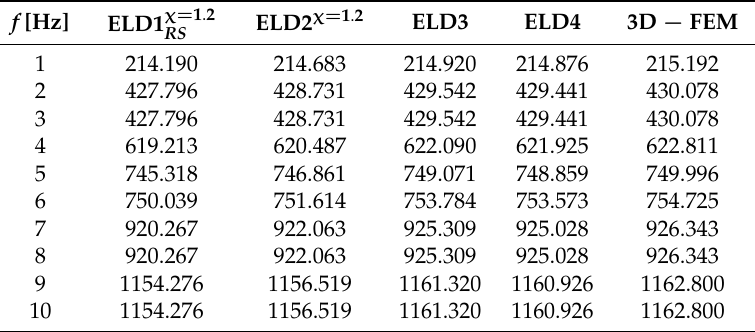
Table 3. First 10 natural frequencies ([Hz]) for a CCCC isotropic square plate ( L x = L y = 2m) of thickness h = 0.1m for several higher-order ELW approaches. The Cheb-Gau-Lob grid distribution is used for the numerical solution assuming I N = I M = 21.